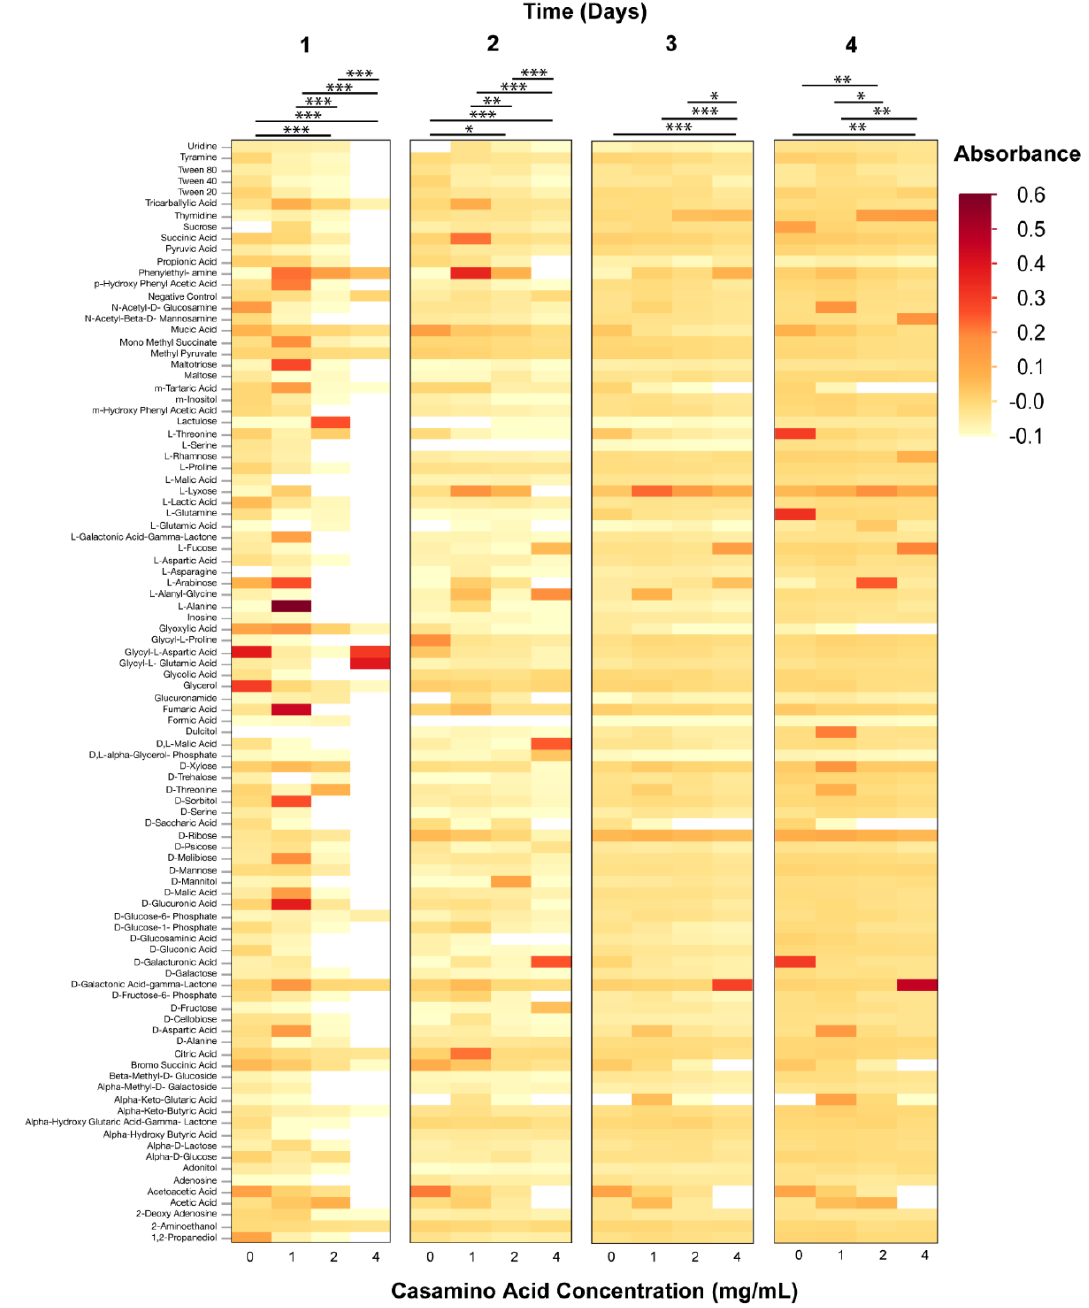
Figure 4. Heat map of PM1 phenotypic microarray data from Wolbachia isolated and maintained in Schneider’s medium supplemented with 10% FBS and different concentrations of Casamino acids ( n = 3 for each treatment). All data were normalized by subtracting absorbance values of control plates containing Schneider’s medium only from absorbance readings of treatment plates. Significant differences between treatments are represented by horizontal bars above each column for each timepoint (t-tests, * p < 0.05, ** p < 0.005, *** p < 0.0005).